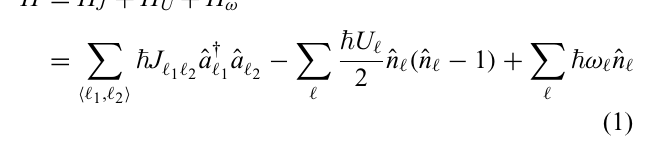
[Fig. 1(c)] can be described using the disordered Bose- Hubbard model with attractive interactions [3,29–32], defined by the Hamiltonian